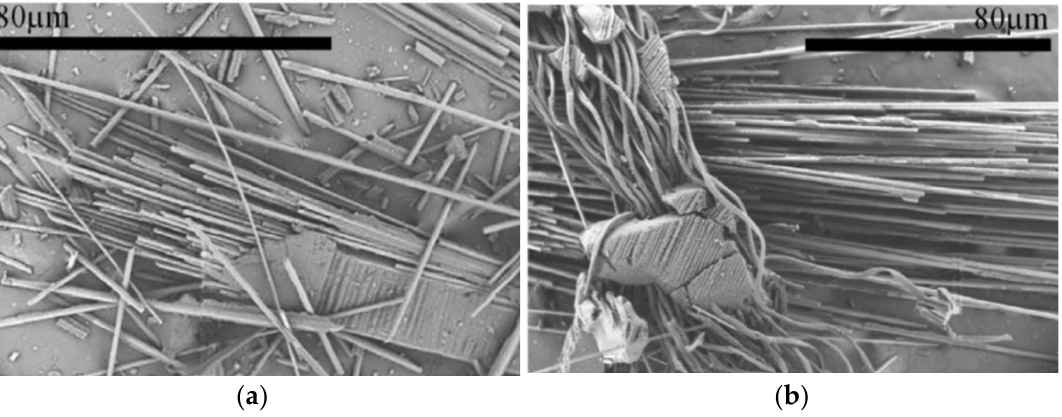
Figure 13. SEM images of shredded rGFs : presence of old polymeric matrix on the fibre surface ( a ); matrix particle on the fibre bundle ( b ) [103].